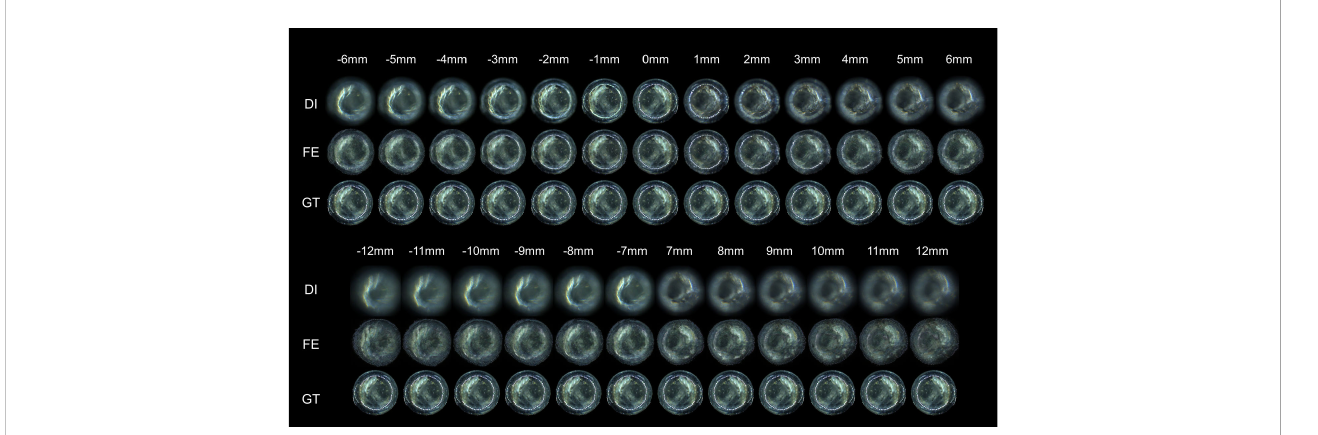
FIGURE 7 Visual comparisons of the focus-extension performance of the IsPlanktonFE network on dark fi eld images of a SiO 2 bead target. The value above each column indicates the defocus distance between the DI and the GT images. The nominal diameter of the SiO 2 bead is